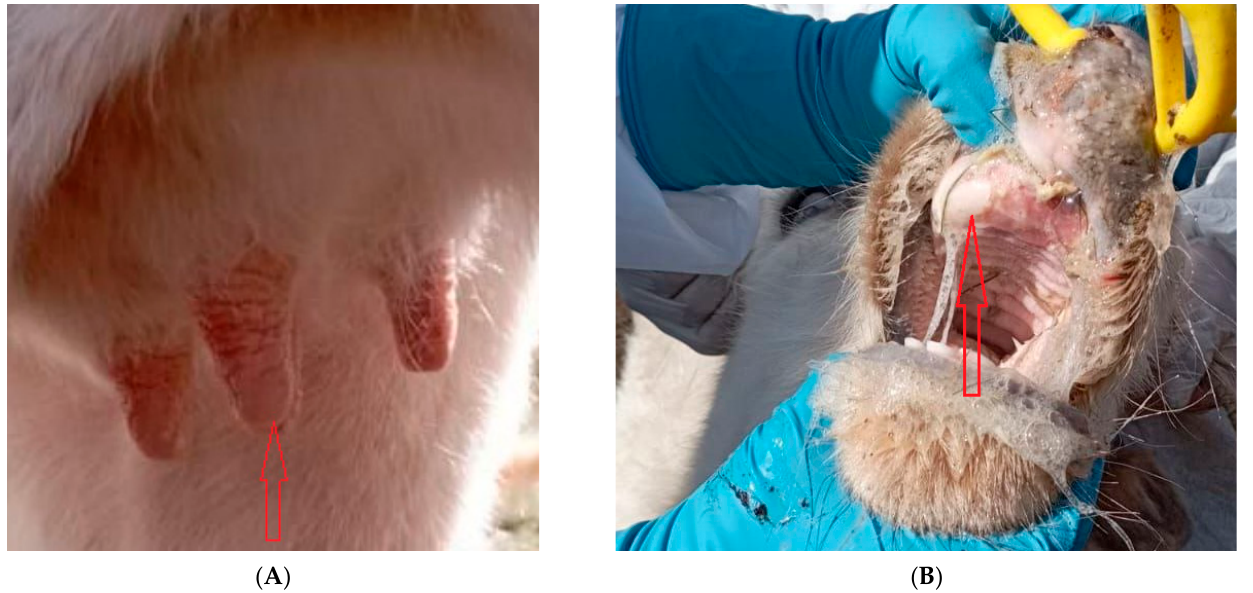
Figure 1. Clinical signs observed at a foot-and-mouth disease outbreak identified in Orenburg oblast in December 2021. ( A ) lesions on the treats, ( B ) aphts in the mouth. In December 2021, two biological samples (aphthous ulcers) were collected from FMD- infected cattle (from two cows owned by one owner) in the Orenburg oblast of the Russian